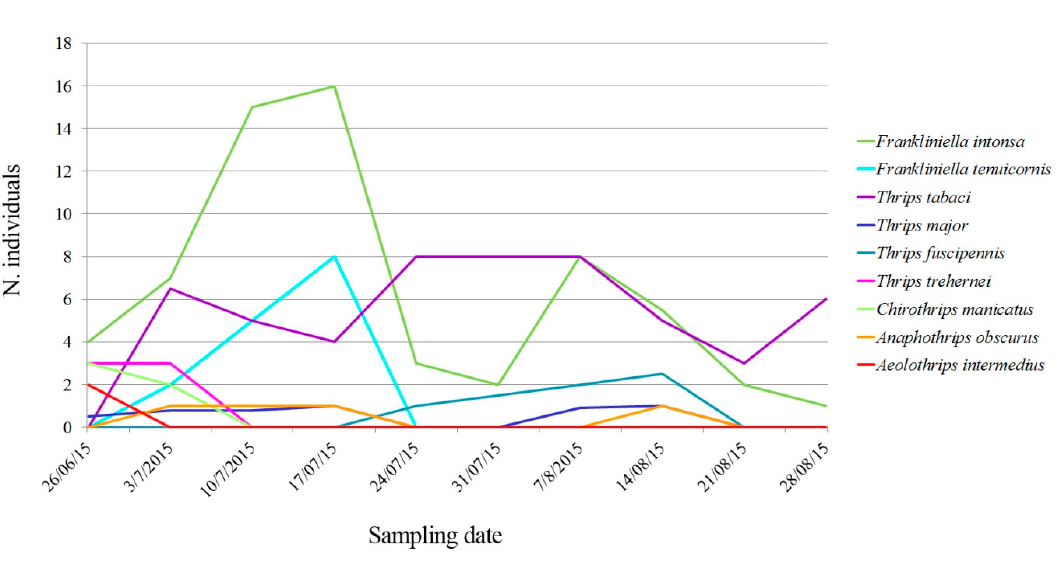
Figure 3. Seasonal fluctuation of thrips species collected on traps. Color codes indicate the different species identified and they are the same reported in the phylogenetic analysis (Figure 1).